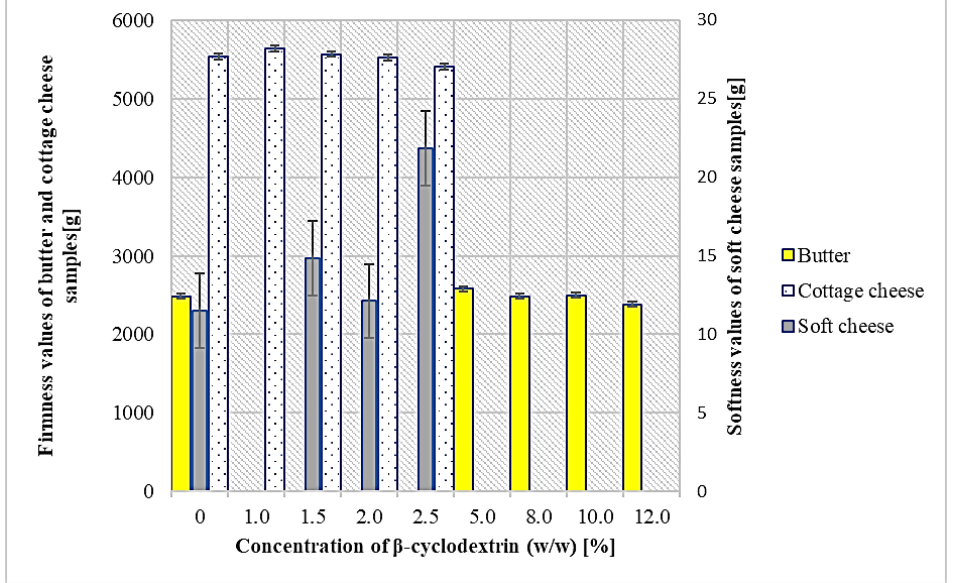
Figure 3. The effect of the concentration of β -cyclodextrin on the firmness and softness values of cottage cheese, butter, and soft cheese, respectively.